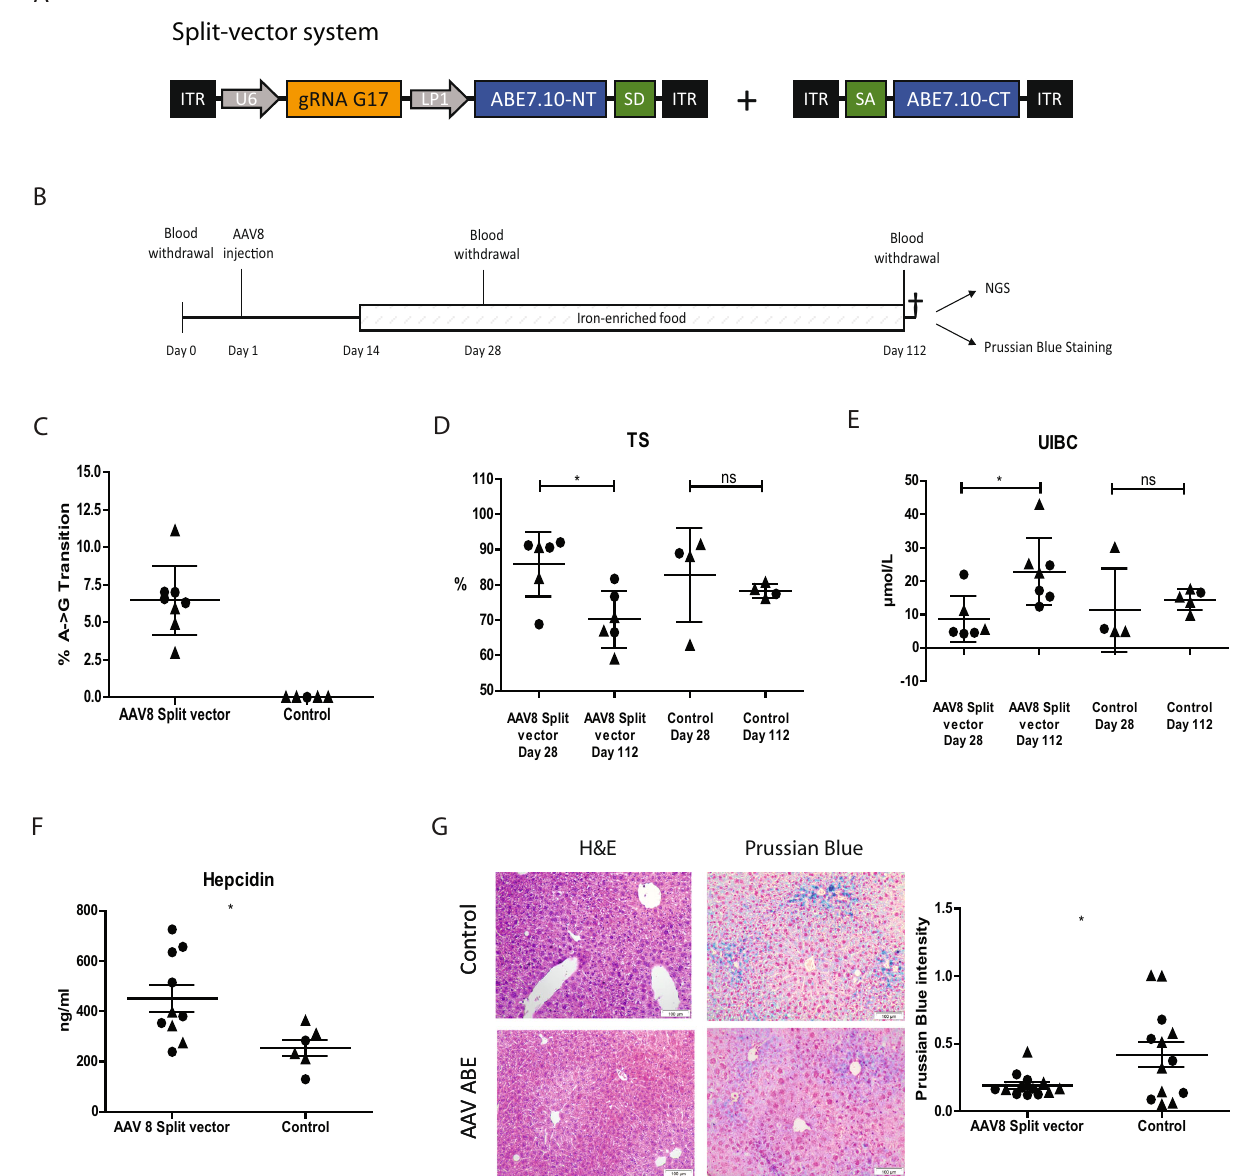
Fig. 3 | In vivo Adenine Base Editing upon low dose AAV split-vector adminis- tration. A Depiction of the split-vector system. AAV_SV1 contains a U6 promoter- driven gRNA gene and the LP1-driven N-terminal ABE7.10 domain. AAV_SV2 con- tains the C-terminal part. B Experimental timeline. Basal blood was withdrawn on day0.Split-vectorwasinjectedonday1.Onday14animalsweresuppliedwithiron- enriched food until the endpoint. A second blood withdrawal occurred on day 28 and a third on day 112. Editing ef fi ciency was assessed by NGS and iron accumu- lation was determined via Prussian Blue staining. C Determination of base con- version rate via NGS four months after low-dose AAV8 split-vector injection. The barsinthescatterdotplotdepictthemeanwiththeSD.Malemicearerepresented in circles, female mice in triangles. Hfe locus was PCR-ampli fi ed from liver DNA prior to NGS ( n= 5 controls, n= 8 treated). D Transferrin saturation was measured from serum withdrawn at day 28 and 112. Statistical signi fi cance was determined using a two-tailed unpaired t test. p value=0.0106 (AAV8 Split vector day 28 vs AAV8Splitvectorday112).Dataarepresentedasmeanvalues+/ − SEM.TS%Day28 85.80±3.731, n= 6;TS%Day11270.21±3.290, n= 6.Thebarsinthescatterdotplot depict the mean with the SD. Male mice are represented in circles, female mice in triangles. E UIBC was measured from serum obtained at day 28 and 112. Statistical